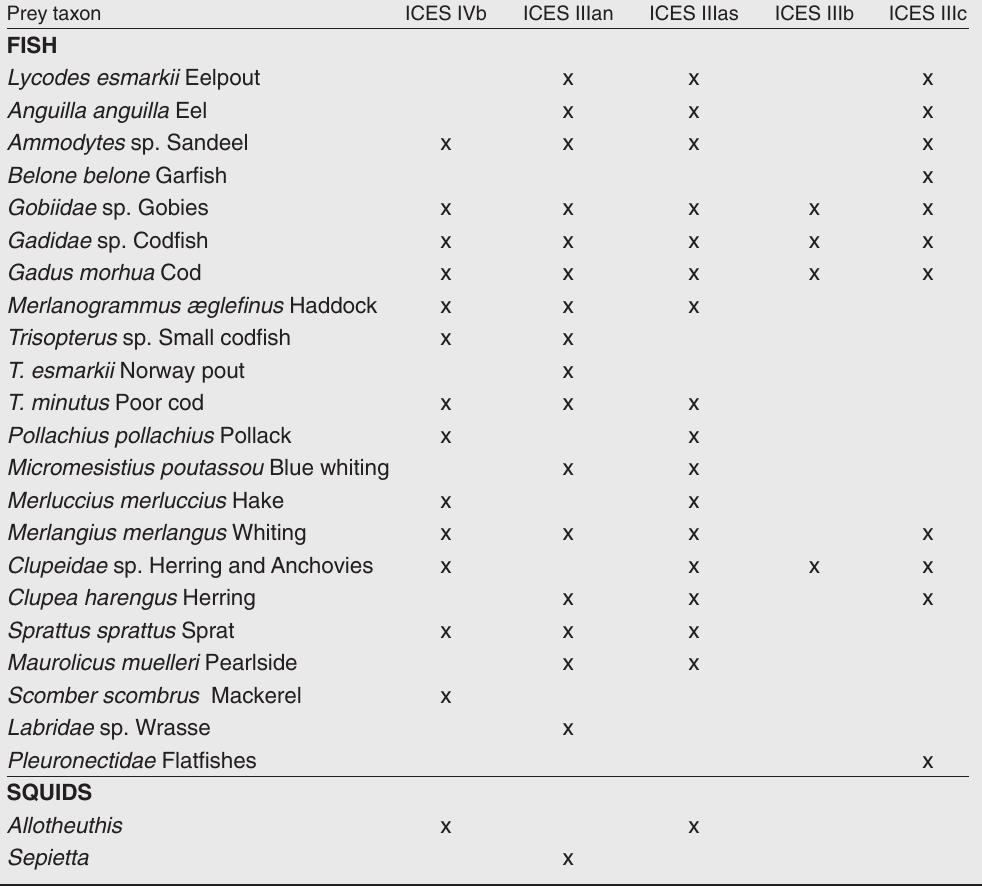
Table 5. Diet of harbour porpoises from Danish waters by ICES areas, in the period 1985- 1997, including previous analyses and new data